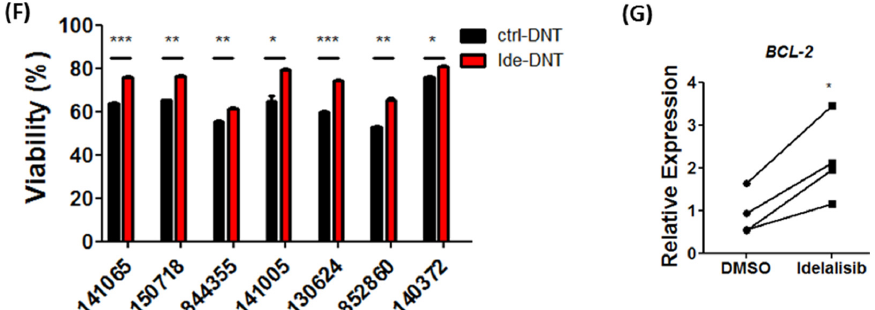
Figure 4. Ide improves fitness of DNTs by inhibiting exhaustion and enhancing viability. ( A ) Expression of exhaustion markers, LAG3 and TIM3, on unstained (dotted line), ctrl-DNT (Red), and Ide-DNT (Black). Representative flow plot is shown (Left). The numbers represent the MFI value (Right). ( B ) The summary of results comparing the relative MFI of LAG3 and TIM3 on the ctrl-DNT and Ide-DNT from five donors. Horizontal bars represent the mean relative MFI and error bars show SEM. ( C ) Expression of the exhaustion-associated transcription factor gene, TOX , relative to the expression of the housekeeping gene, HPRT , determined by qPCR. Each paired symbol represents DNTs from one individual. ( D ) Production of TNF α and IFN γ by the ctrl-DNT and Ide-DNT with or without ex vivo stimulation. The ctrl-DNT and Ide-DNT were treated with a protein transport inhibitor, followed by stimulation using anti-CD3/CD28 activation beads for 4 h. Representative flow plot is shown (Left). The numbers represent the frequency in each gate. Bar graph shows the percentage of ctrl-DNT (black) and Ide-DNT (red) expressing TNF α , IFN γ , and TNF α and IFN γ (Right). The result shown is a summary of three experiments. ( E ) Frequency of viable ctrl-DNTs and Ide-DNTs on day 17 of expansion. The cell viability was determined with Annexin V and 7-AAD staining using flow cytometry. Flow plot shows a representative image of cell viability (Left). Dot plot shows summary of viability results using DNTs from five different donors (Right). Horizontal bars represent the mean, and the error bar shows SEM. ( F ) Viability of ctrl-DNTs and Ide-DNTs after co-culture with primary AML cells from seven different patients. Ctrl-DNTs and Ide-DNs were co-incubated with primary AML cells at 4:1 effector-to-target ratio for 2 h. Subsequently, the viability of DNTs (gated on CD45 high CD3 + CD33/CD34 − ) were determined using flow cytometry. ( G ) Expression of the anti-apoptotic gene, BCL2, on ctrl-DNT and Ide-DNTs relative to the expression of the housekeeping gene, HPRT , was determined by qPCR. Each paired symbol represents DNTs from one donor. * p < 0.05, ** p < 0.01, *** p < 0.001 .